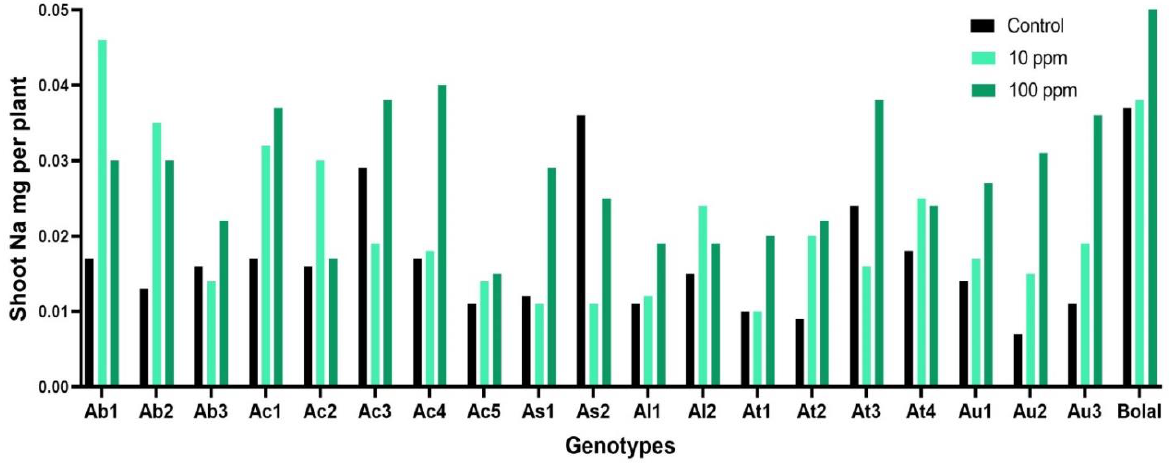
Figure 3. Variation in the SNa (shoot sodium) uptake of 19 Aegilops genotypes and the B tolerant check cultivar, Bolal 2973, in Control (3.1 μM B), toxic B (10 ppm B) , and highly toxic B (100 ppm B).